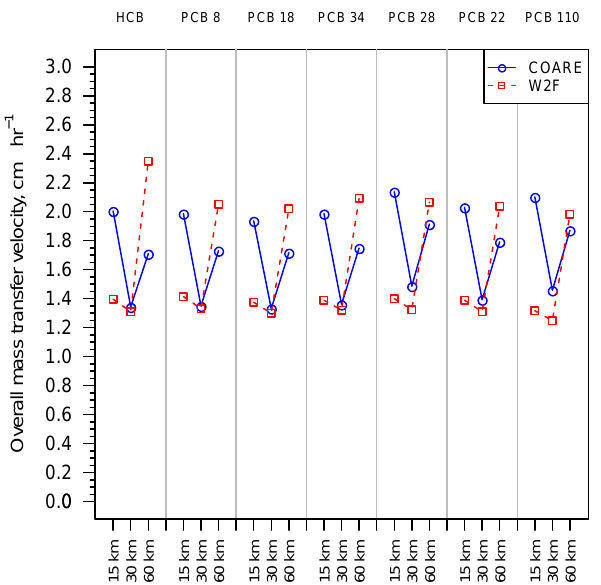
Fig. 3. Comparison of modified Bowen ratio and Whitman two-film fluxes to atmospheric concentrations measured at the upper (8.5m) and lower (1m) platforms at the 15-, 30-, and 60-km fetch stations. MBR and W2F fluxes are plotted in the upper panel, both with esti- mated uncertainty given by the error bar. The atmospheric concen- trations are plotted in the lower panel, with error bars indicating the uncertainty estimates in Table 2. Note that the HCB concentration was divided by ten to put it on the same scale as the other concentra- tions. In five of seven cases for which a significant non-zero MBR flux was measured, concentration increased significantly with fetch at 1-m height between the 15 and 60 km stations, with the exception of PCB 28.